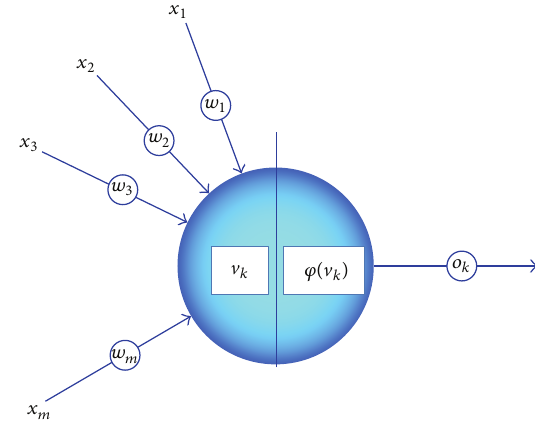
Figure 2: Artificial neuron node model ( 𝑥 1 ,𝑥 2 ,...,𝑥 𝑚 : input data; , 𝑤 ,...,𝑤 𝑤 1 2 𝑚 : weight coefficient; weight coefficients; 𝜑 is the activation function of the neuron node; 𝑜 𝑘 is the response of the neuron node in the calculation) [8].